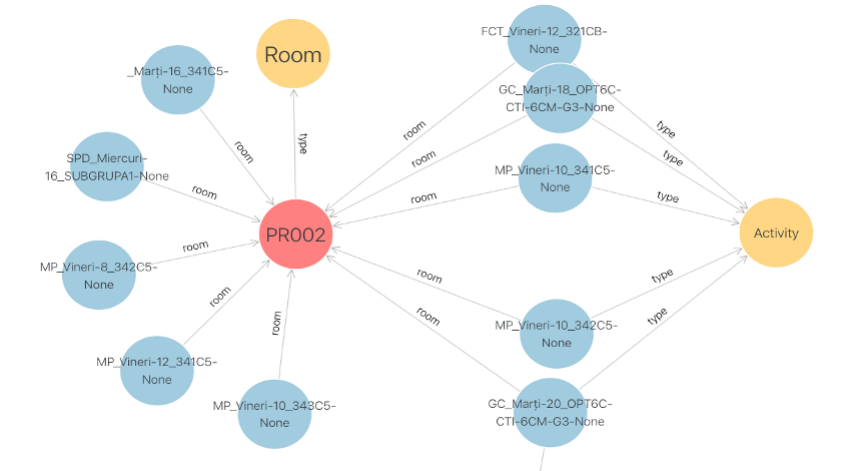
Figure 4. GraphDB’s knowledge graph visualization.